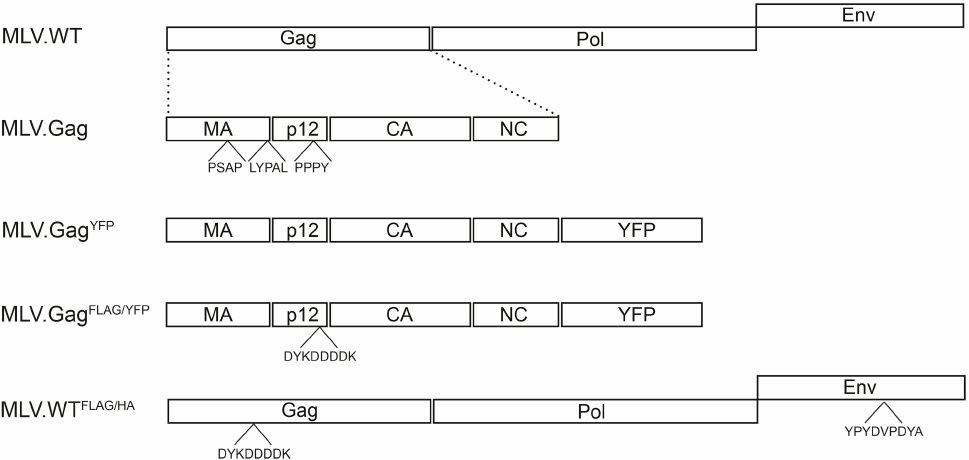
Figure 1. Schematic depiction of the MLV constructs. MLV.WT indicates the retroviral genome organization with the Gag, Pol, and Env ORFs of MLV. Below, the domain architecture of Gag with the matrix (MA), p12, capsid (CA), and nucleocapsid (NC) domains is depicted, and putative late domains (PSAP, LYPAL, and PPPY) are indicated. MLV.Gag YFP carries the Gag ORF with a C -terminal YFP fusion, while MLV.Gag FLAG/HA encodes an additional FLAG tag (DYKDDDK) within the p12 region. MLV.WT FLAG/HA depicts a modified MLV genome carrying the FLAG tag within Gag and a HA epitope (YPYDVPDYA) within the ENV ORF.